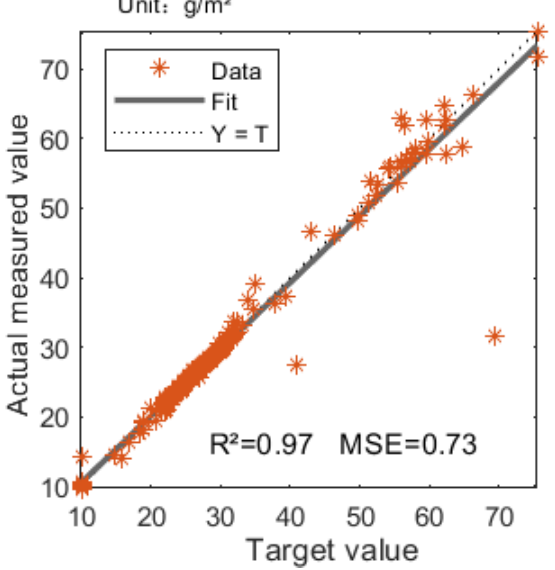
Figure 10. The evaluation of multi-factor combined BP neural network. The X -axis and Y -axis represent the target and actual measured values of grazing intensity. Data refers to the data set involved in the calculation, Y = T represents the ideal situation when there is no deviation between the measured value and the target value, and Fit represents the actual situation achieved by the model.